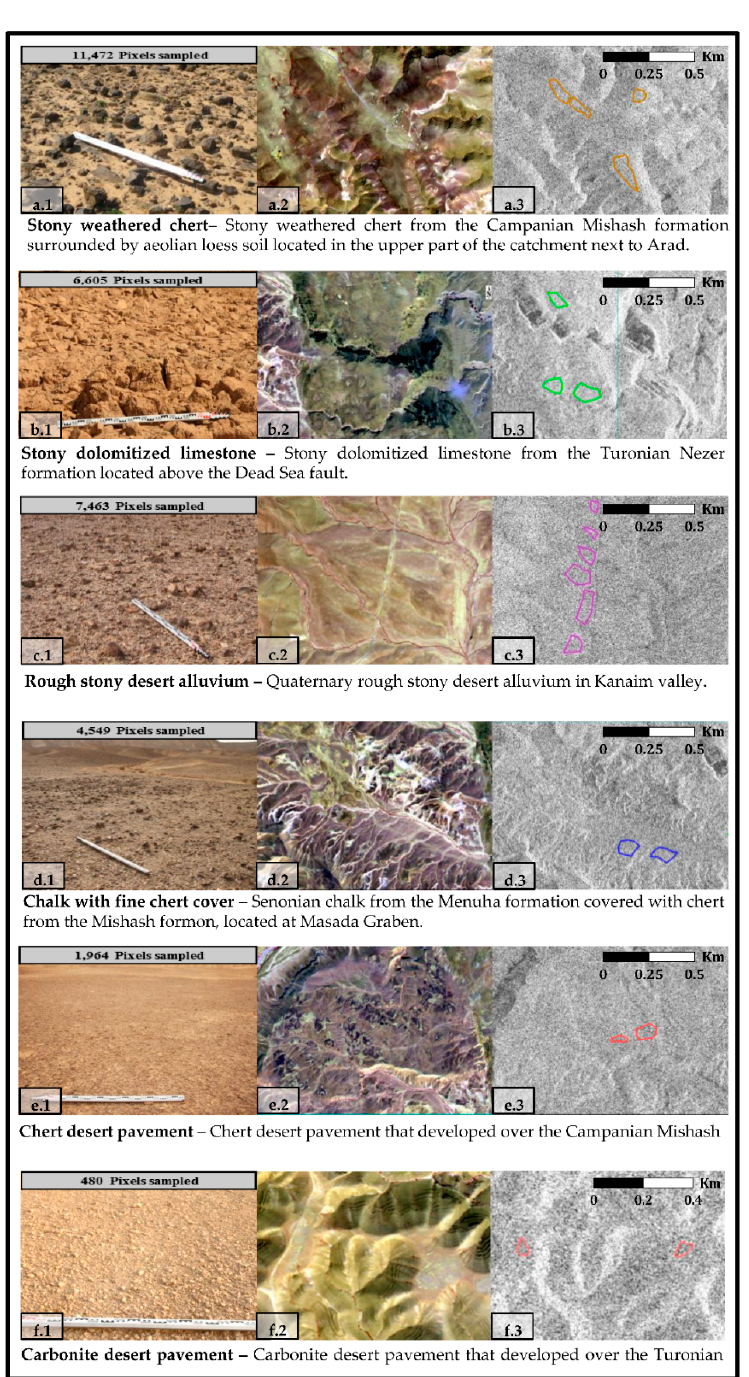
Figure 3. The six geomorphological units and the regions of interest (ROIs) from which the pixels were sampled for roughness extraction (a.1–f.1). The geomorphological unit as photographed in the field and the number of sampled pixels for each unit (a.2–f.2). WorldView-2 image of the ROI region (a.3–f.3). The ROIs used for roughness extraction from COSMO-SkyMed image.